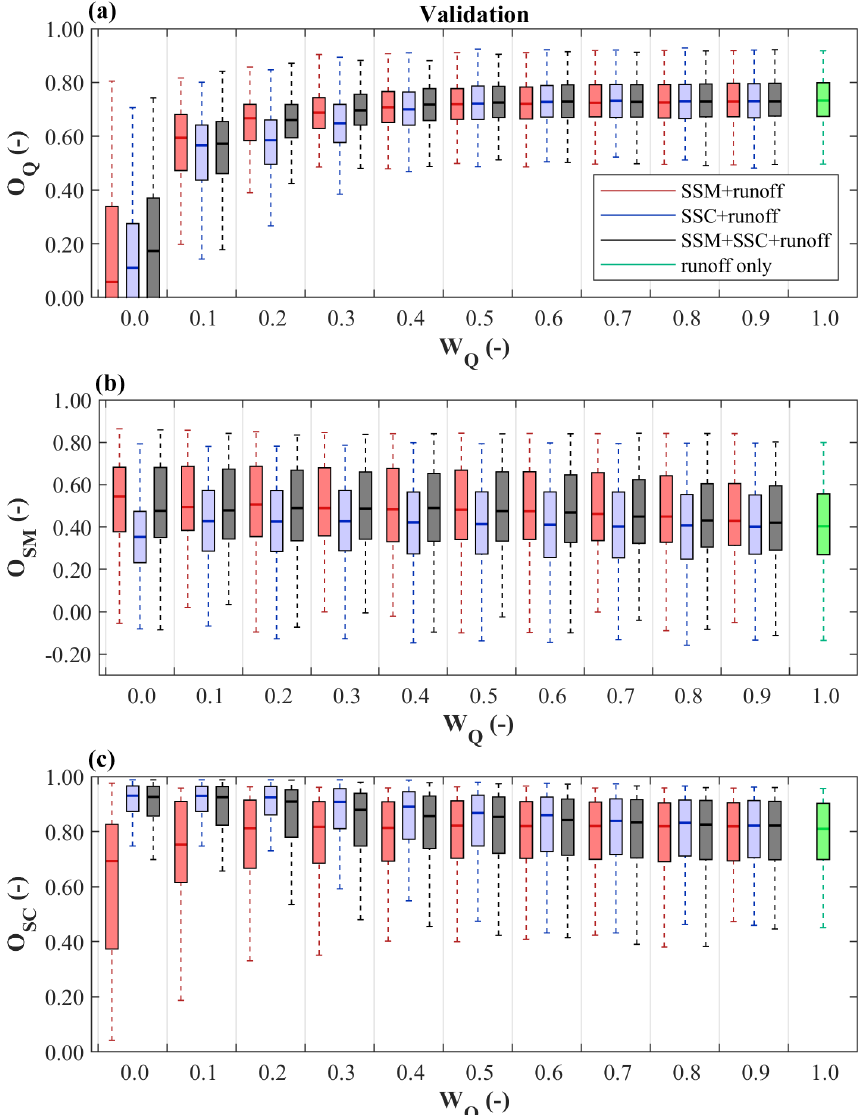
Figure 4. Hydrologic model performance for the following three multiple objective calibration variants: calibration to satellite soil moisture and runoff (red boxes), calibration to satellite snow cover and runoff (blue boxes), and calibration to satellite soil moisture, snow cover, and runoff (gray boxes). Panels (a) , (b) , and (c) show runoff (Eq. 2), soil moisture (Eq. 5), and snow cover (Eq. 6) model efficiency for different weights of the runoff objective in the validation period 2010–2014, respectively. w Q = 1 represents calibration to runoff only. Boxes represent the values from the different catchments, and the size of the boxes represents the spatial variability across the 213